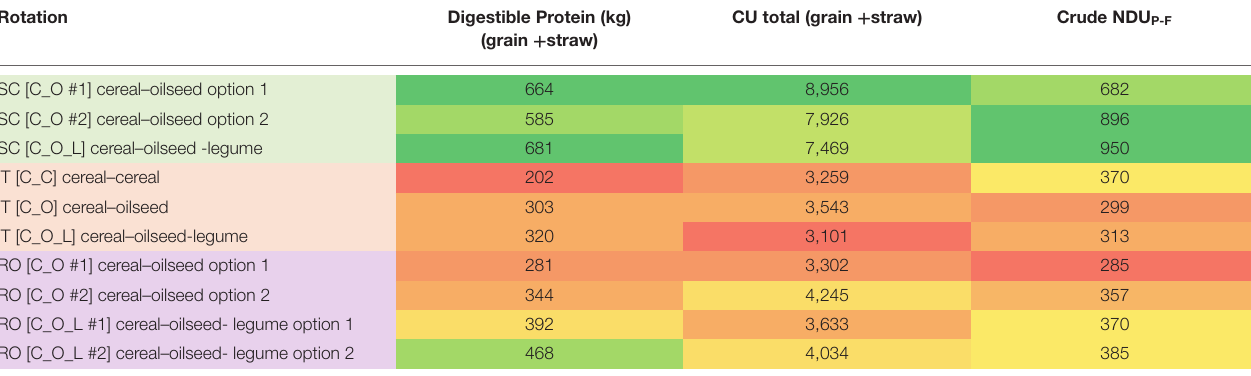
TABLE 2 | Outputs of the rotations in terms of DP, CU, and NDU P − F per hectare per year of each rotation in Scotland (SC), Italy (IT), and Romania (RO). Rotation Digestible Protein (kg) CU total (grain + straw) Crude NDU (grain + straw)